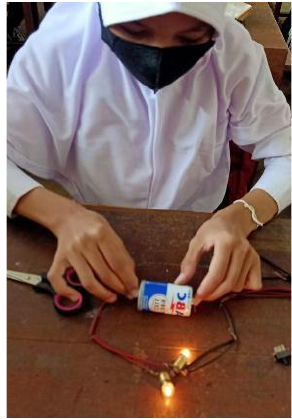
Figure 6 : Students design a simple electric